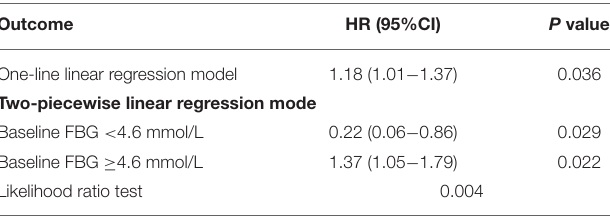
Adjusted for age, gender, smoking, drinking, prior stroke, hypertension, pneumonia, atrial fibrillation, NIHSS score at admission, blood urea nitrogen, serum creatinine. FBG, fasting blood glucose; HR, hazard ratio; CI, confidence interval.